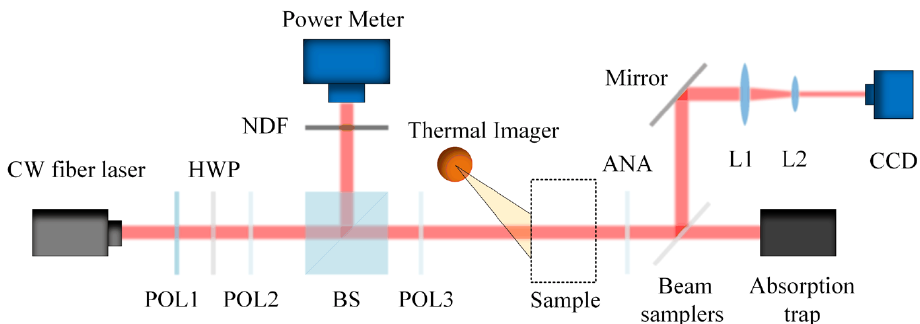
Figure 5. CW laser damage resistance test system. POL: polarizer, HWP: half wave plate, BS: beam splitter, NDF: neutral density filter, ANA: analyzer, L: lens.